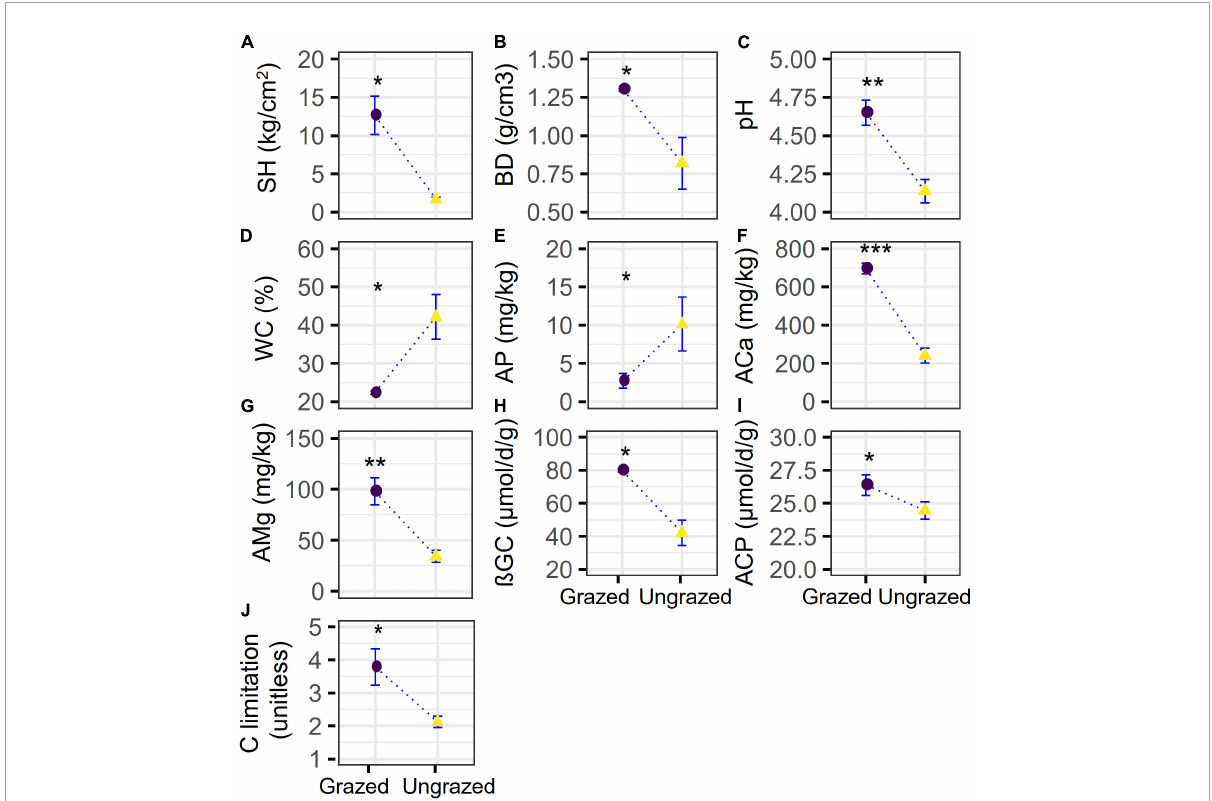
FIGURE1 Soil physical, chemical property, enzyme activity, and carbon limitation under grazed and ungrazed. The differences in (A) soil hardness (SH), (B) soil bulk density (BD), (C) pH, (D) water content (WC), (E) phosphorus availability (AP) content, (F) calcium availability (ACa) content, (G) magnesium availability (AMg) content, (H) β -1-4-glucosidase ( β GC), (I) acid phosphatase (ACP), and (J) microbial carbon limitation between grazed and ungrazed. * p < 0.05, ** p < 0.01, and *** p <